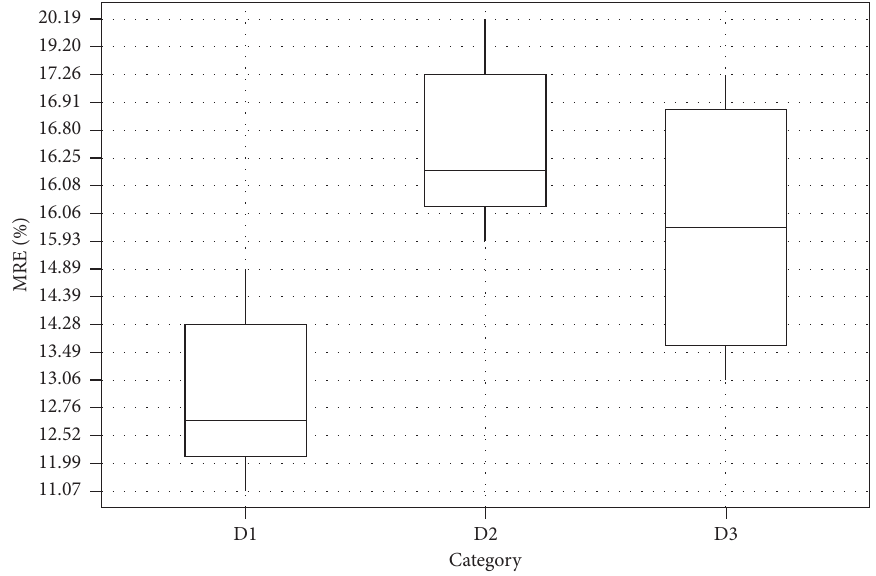
Figure 10: Boxplots of MREs with different parking duration categories.